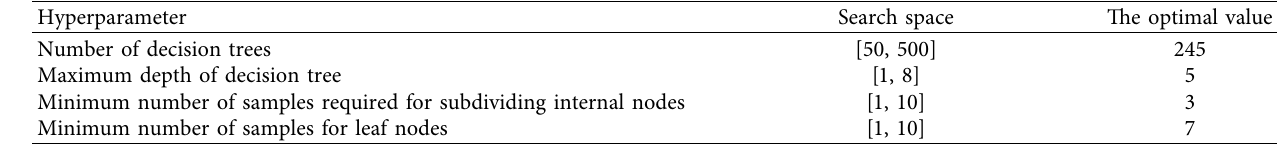
Table 5: Optimized values of RF hyperparameters.